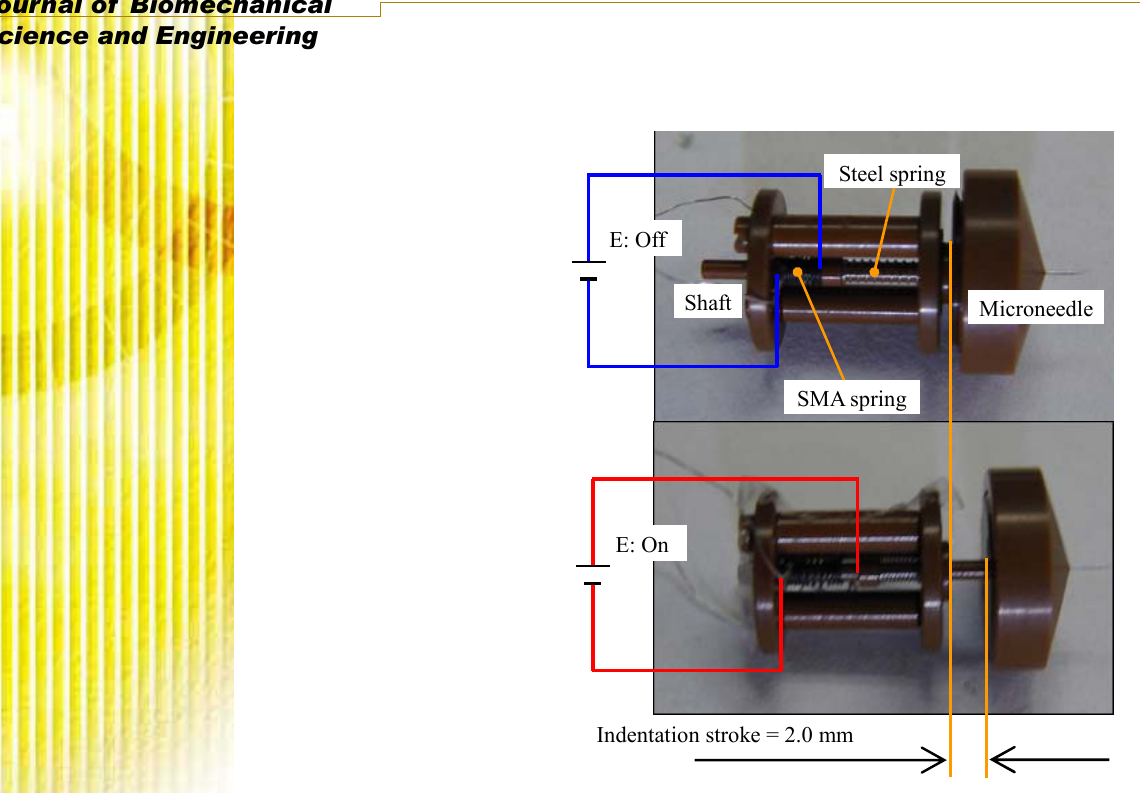
Figure 5. Action of microneedle for indentation by Joule’s heating of SMA coil spring transducer.